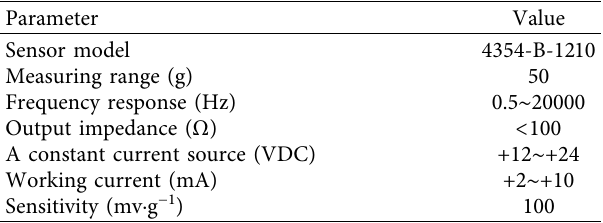
Table 2: Te main technical parameters of the